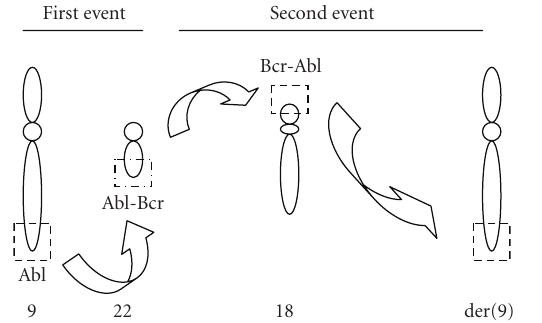
Figure 3: The two-step t(9;18;22) translocation diagram. The first event is classic translocation t(9;22). The second event is transloca- tion between der(22) and chromosome 18p11 and between der(18) and